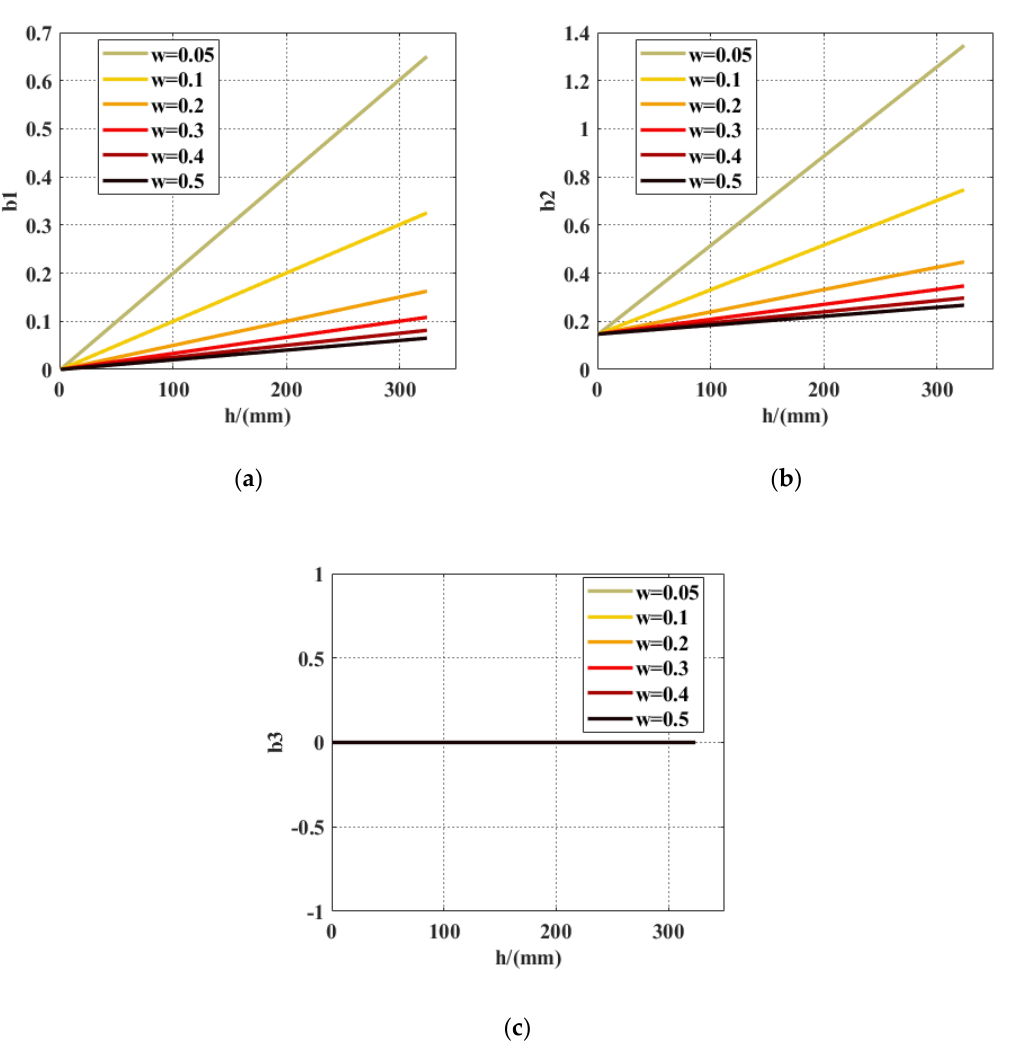
Figure 11. ( a ) The change curve of b 1 at different air–water trans–media velocities; ( b ) The change curve of b 2 at different air–water trans–media velocities; ( c ) The change curve of b 3 at different air–water trans–media velocities.